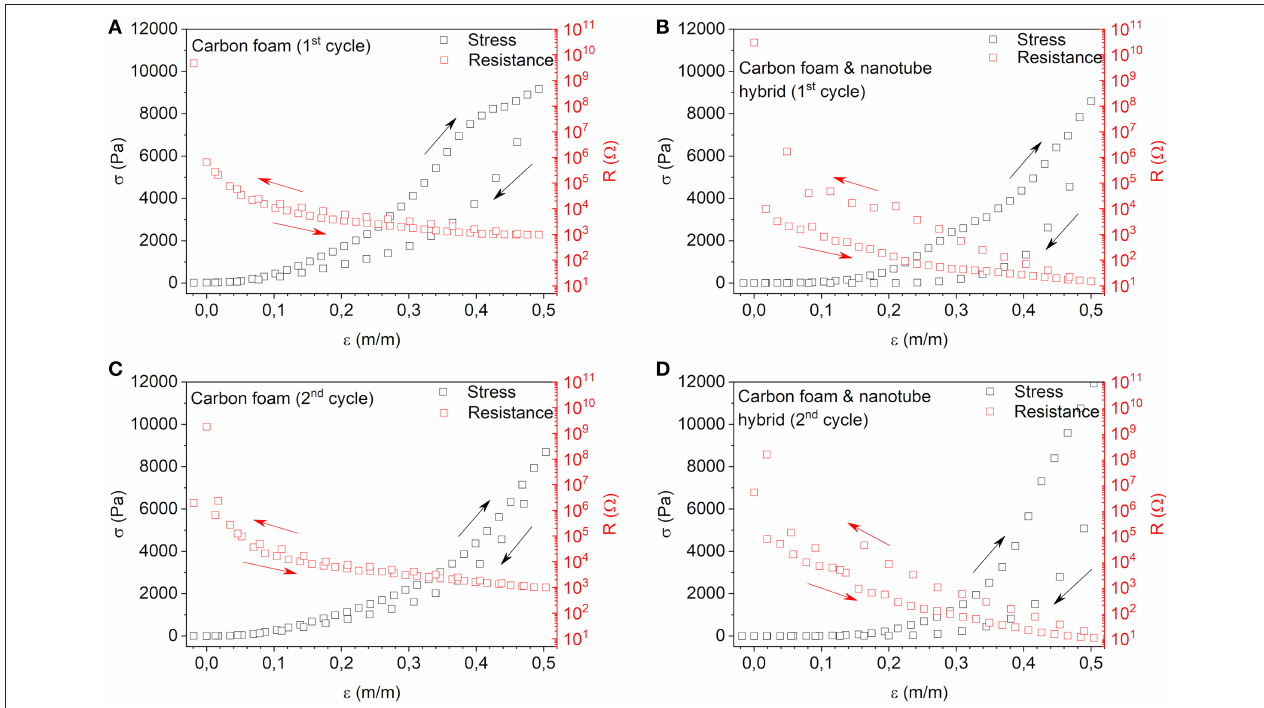
FIGURE 2 | Electrical resistance and mechanical stress as a function of strain for (A) carbon foam and (B) hierarchical carbon foam and carbon nanotube hybrid structures measured in the first deformation cycle up to ∼ 50%strain and back to the starting position. Panels (C,D) display the measured data obtained in the second deformation cycle for the corresponding specimens. The original dimensions (width × length × height) of the samples are 11.1 × 9.0 × 2.0 mm 3 (carbon foam) and 9.6 × 9.3 × 2.0 mm 3 (carbon foam and nanotube hybrid). The first resistance data point in each plot below 0% strain indicates insufficient contact with the electrodes in the experimental